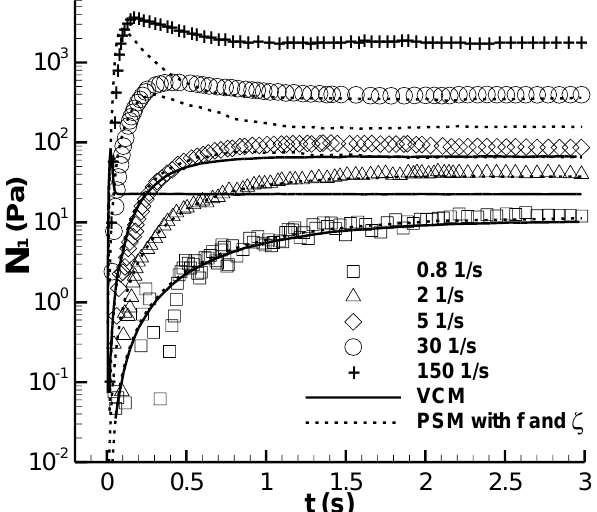
Figure 1. Transient N 1 of the CPyCl/NaSal solution in the start-up experiment. Symbols are the experimental data in Figure 8 in the study conducted by Pipe et al. [3], and lines are the calculations. The calculated values for the VCM model are at 0.8, 5, and 150 s − 1 [3], and “PSM with f and ζ ” is the present